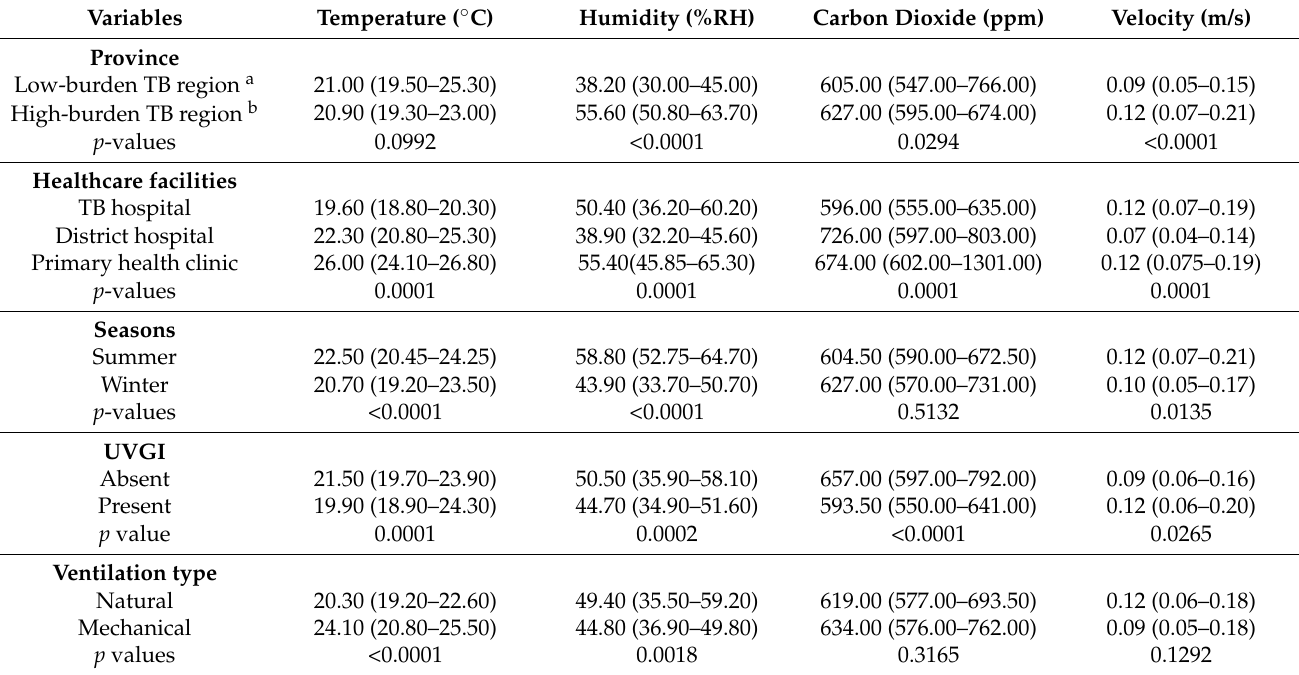
Table 4. Comparison of microclimate parameters (medians and interquartile ranges, IQRs) by categorical indicators.